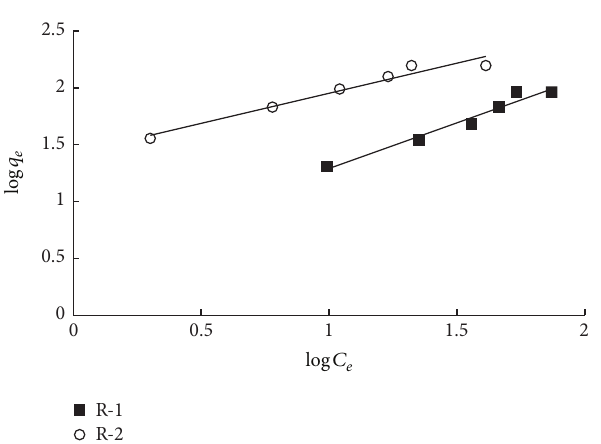
Figure 10: Temkin adsorption